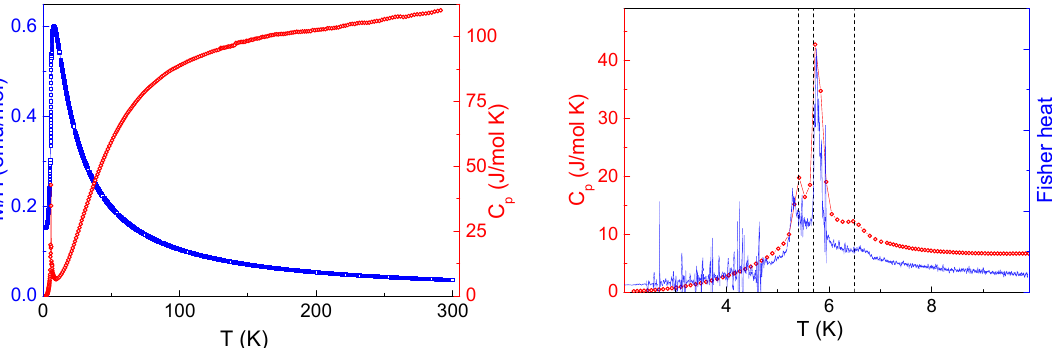
Figure 2. (Left panel ): Temperature dependences of specific heat C p and magnetic susceptibility χ = M / H at µ 0 H = 0.1 T in TbTe 3 . ( Right panel ): Fisher specific heat d[(M/H)T]/dT vs. T and C p vs. T enlarged. Vertical dash lines denote temperatures of magnetic phase transitions at T N 1 , T N 2, and T N 3 .